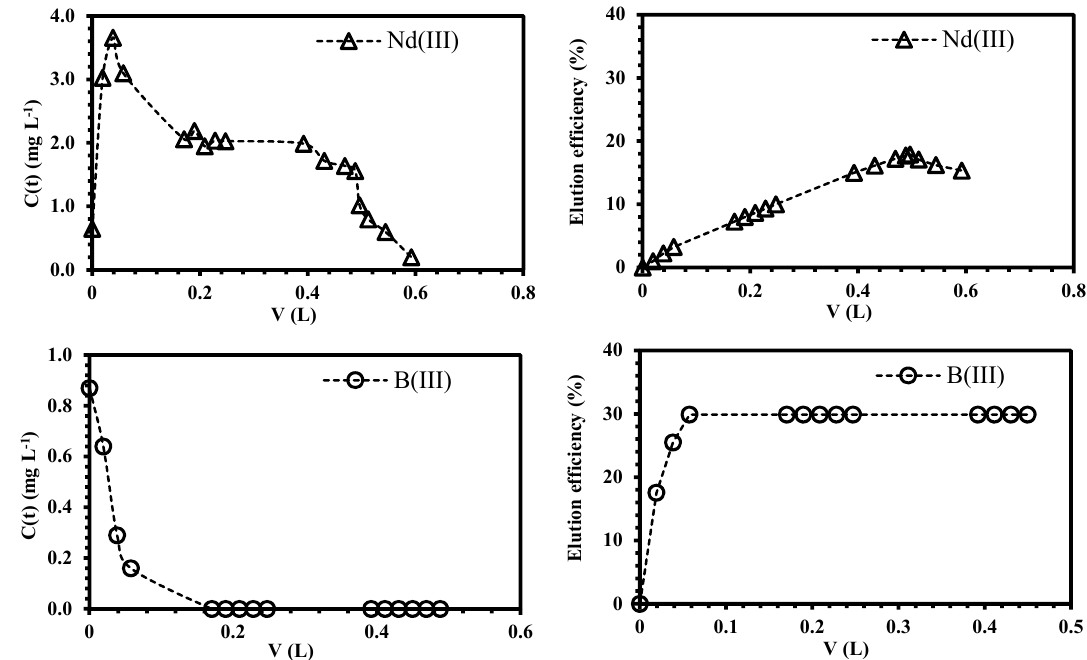
Figure 9. Simultaneous desorption of neodymium and boron from loaded ChiFer(III) material as fixed ‐ packed sorbent. ( Left side: Recovery metal concentration as a function of the volume (L), dashed line: desorption trend; right side: Elution efficiency as a function of the volume (L); dashed line: efficiency trend; T: 20 °C; internal diameter of the column, Ø: 1.8 cm; bed depth: 23 cm; flow rate: 0.01 L h − 1 ; Eluent: demineralized water at pH: 3.5).